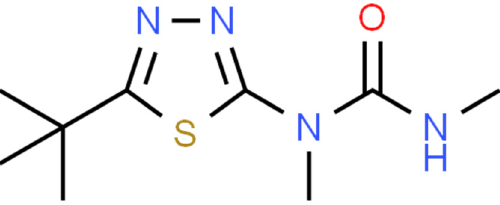
Figure 1. The chemical structure of tebuthuiron. Retrieved from http://www.chemspider.com/ (ac-